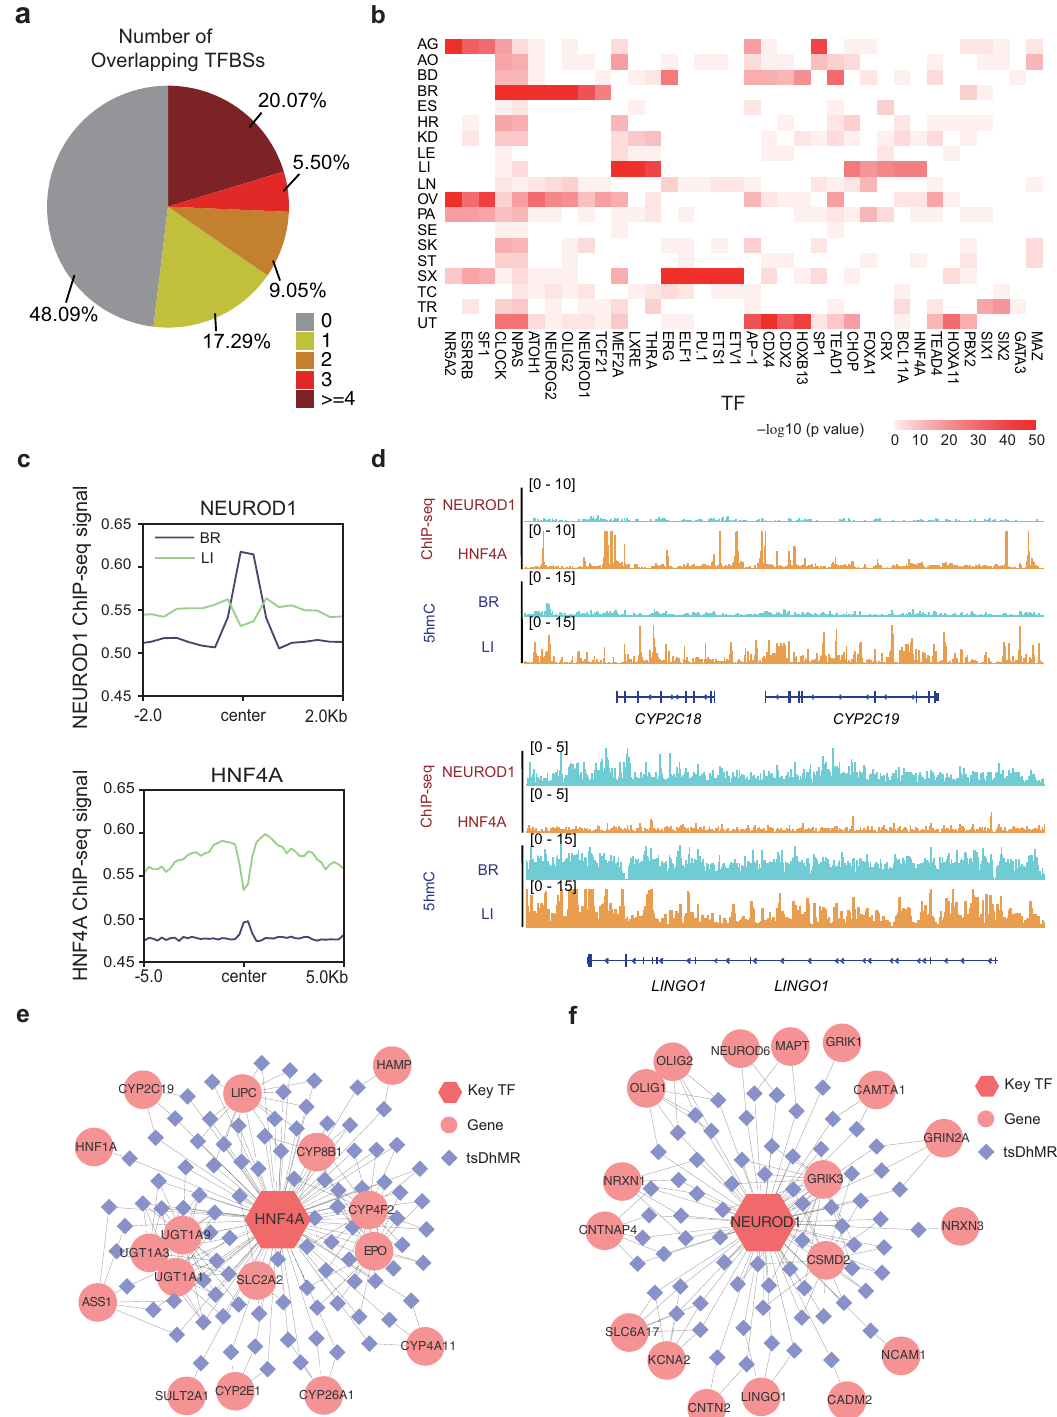
Fig. 6b, c). Taking NEUROD1 and HNF4A as examples, NEU- ROD1 plays an important role in the regulation of the differ- entiation process of various nervous system cells during